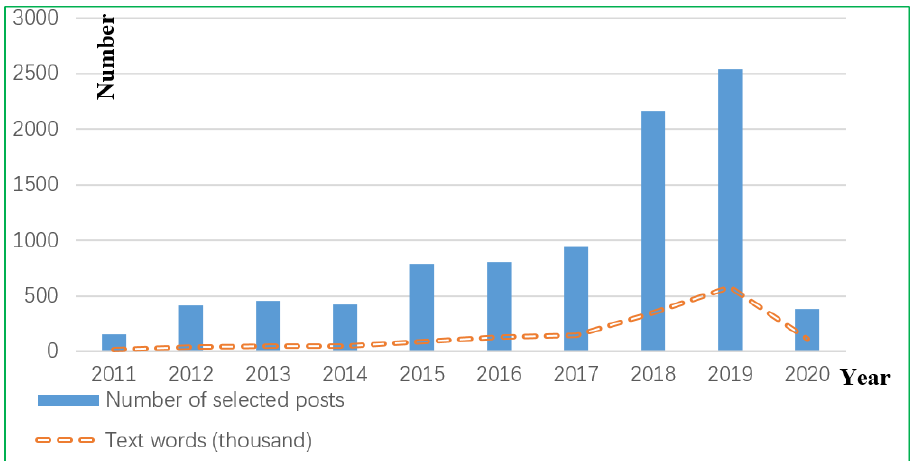
Figure 1. Number of Weibo posts and words by year in study dataset.